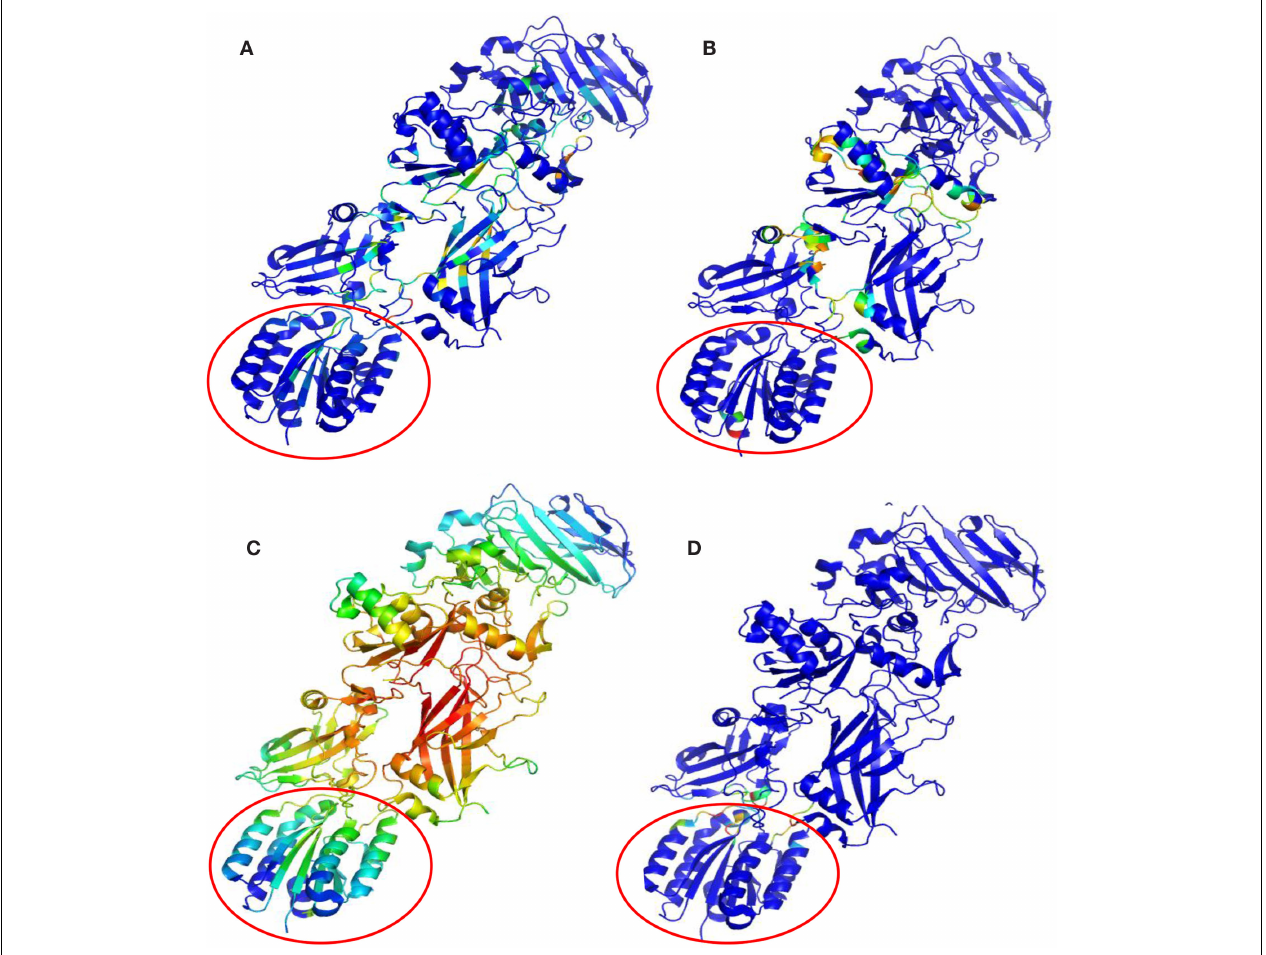
FIGURE 5 | Maps of PCN descriptors on protein structures: complex PA–CGM2 (PDB: 1T6B): (A) betweenness centrality; (B) participation coefficient P ; (C) closeness centrality; (D) inter-chain degree . The CMG2 receptor is highlighted by the empty circle.